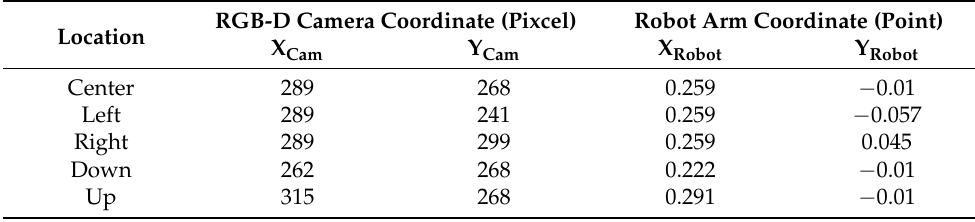
Table 2. Coordinates with respect to the camera and the robot arm corresponding to the five calibration